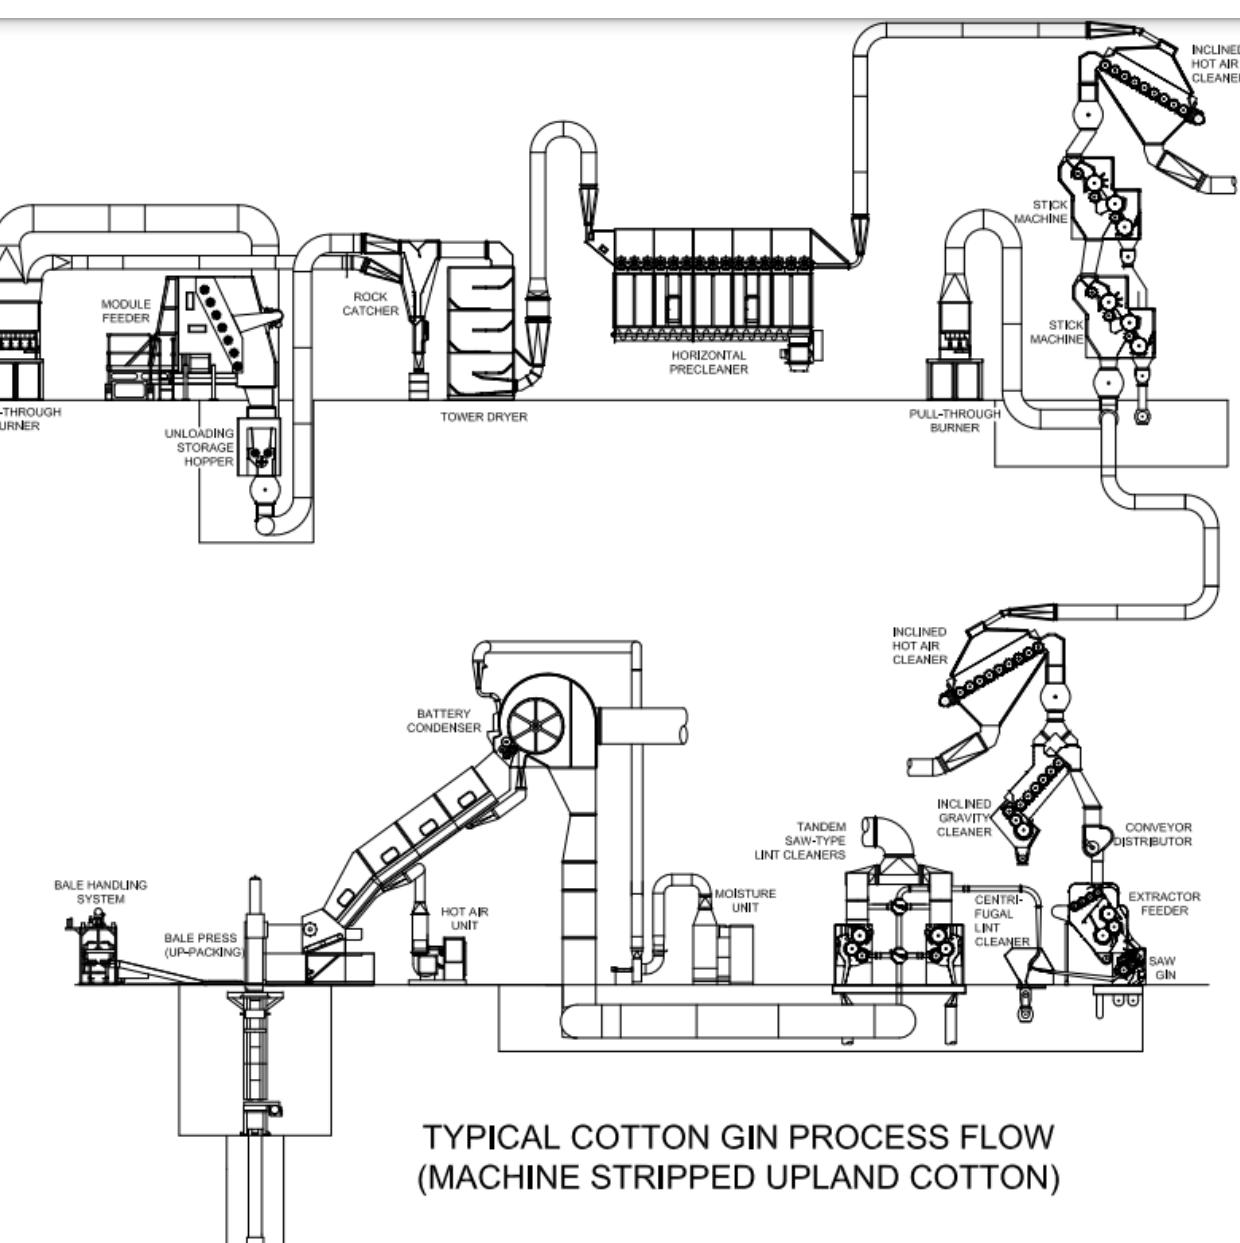
Figure 3. A typical sequence/layout of cotton gin equipment (Provided by Lummus Corporation, Savannah, GA, USA).